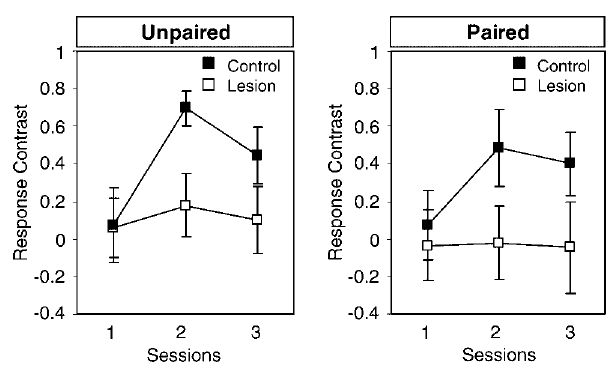
Figure 6. Effects of amygdala lesions on conditioned reinforcement . Graphs show the contrast in responding for the conditioned cue B, which had been paired with O2, and the control cue. The contrast was calculated as ((R + − R − )/(R + + R − )).( Left )RespondinginratsinwhichtheO2outcomewas not devalued. ( Right ) Responding in rats in which the O2 outcome was deval- ued.Controlrats(closedboxes)exhibitedanincreaseindifferentialresponding across days and there was no effect of devaluation. Lesioned rats (open boxes) exhibited no evidence of differntial responding, whether or not the outcome had been